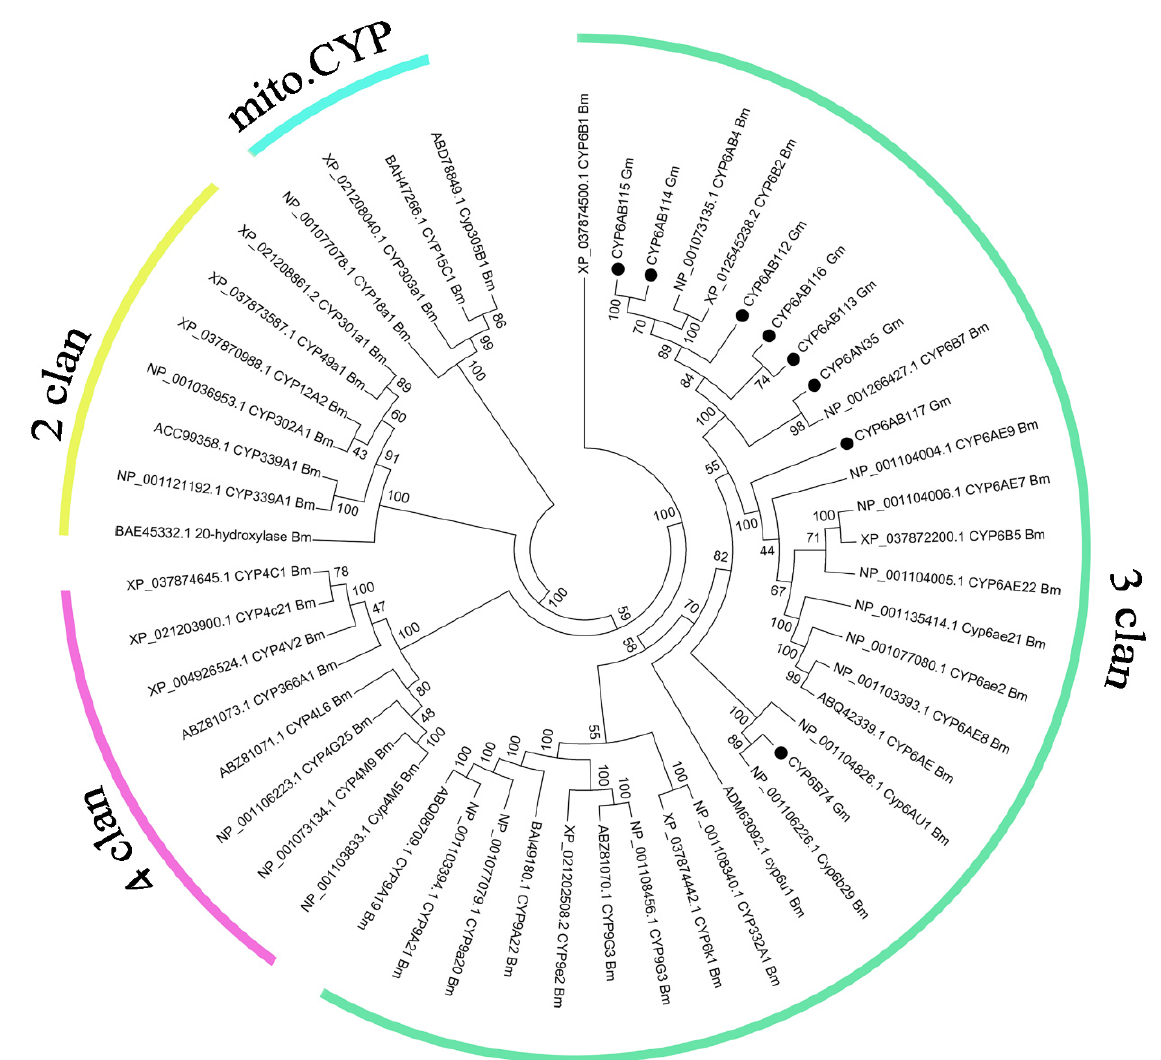
Figure 2. Phylogenetic analysis of eight CYP6 genes in G. molesta and B. mori CYPs. Forty-three CYP sequences from B. mori were used to construct this phylogenetic tree. The eight G. molesta CYPs are indicated by “ • ”.